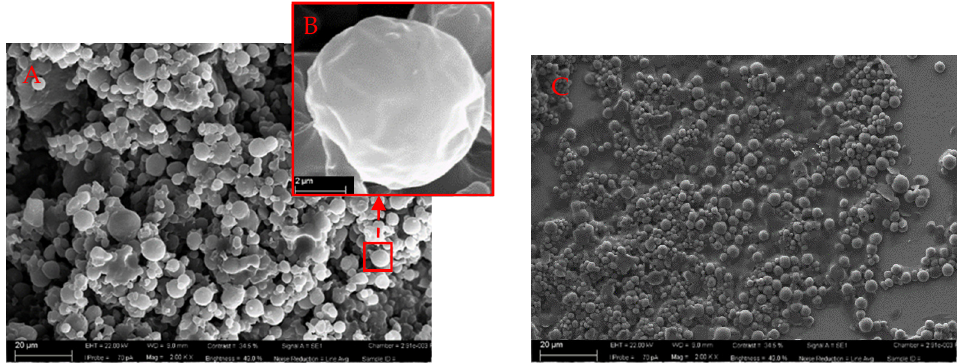
Figure 6. SEM micrographs: ( A ) CC- α -T SLNs at magnification of 2000 × and ( B ) 18,000 × ; ( C ) CH+ α - T particles at magnification of 2000 ×